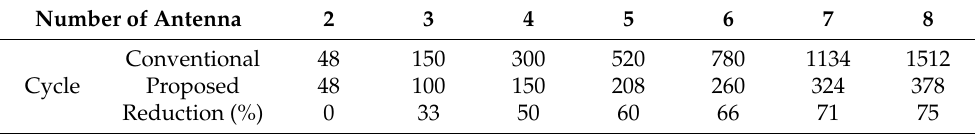
Table 1. Comparison of the cyclic Jacobi method cycles according to the number of antennas. Number of